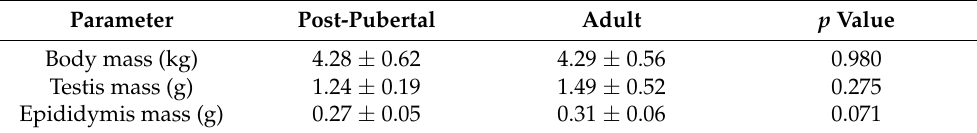
Table 1. Body mass, testis mass, and epididymis mass in <1-year-old (post-pubertal, n = 9) and >1-year-old (adult, n = 7) sexually mature tomcats. Parameter Post-Pubertal Adult p Value Body mass (kg)